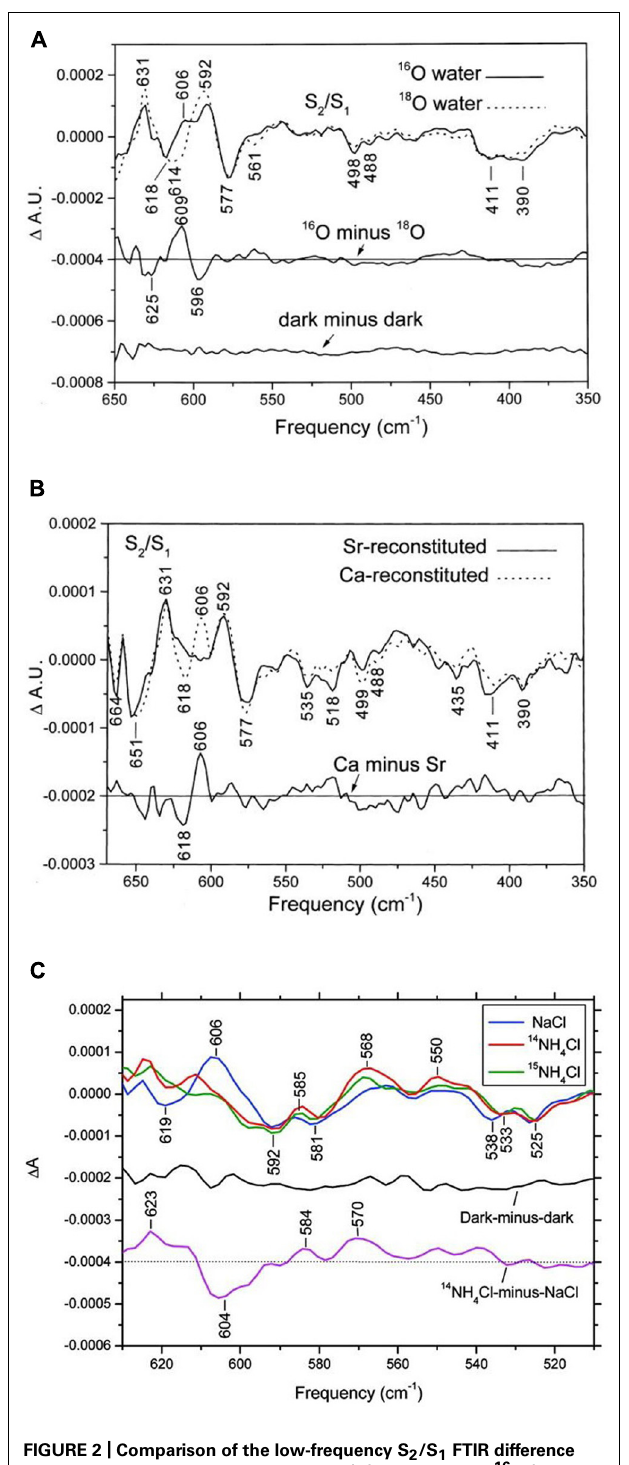
FIGURE 2 | Comparison of the low-frequency S 2 /S 1 FTIR difference spectra of spinach PSII core complexes (A) in buffered H 216 O (solid line) or H 218 O (dotted line), (B) with Sr 2 + -reconstitution (solid line) or Ca 2 + -reconstitution (dashed line), and (C) S 2 Q A– /S 1 Q A FTIR difference spectra with 50 mM NaCl (blue line), 50 mM 14 NH 4 Cl (red line), or 50 mM 15 NH 4 Cl (green line). The sample temperature was 250